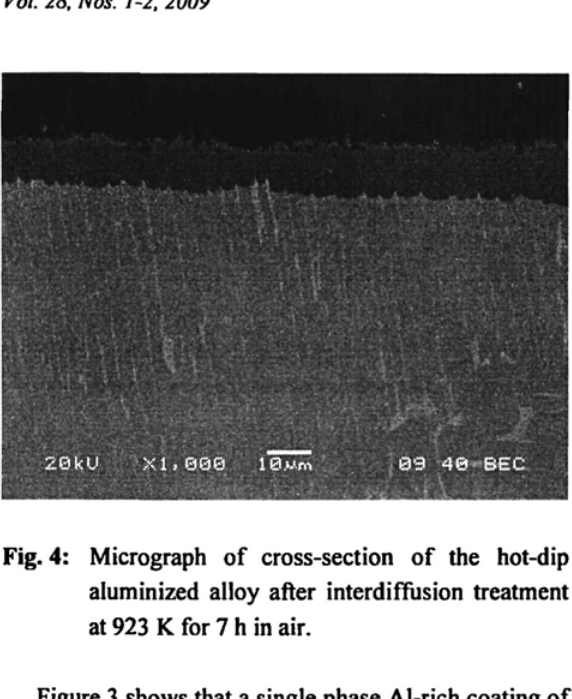
Fig. 4: Micrograph of cross-section of the hot-dip aluminized alloy after interdiffusion treatment at 923 K for 7 h in air.